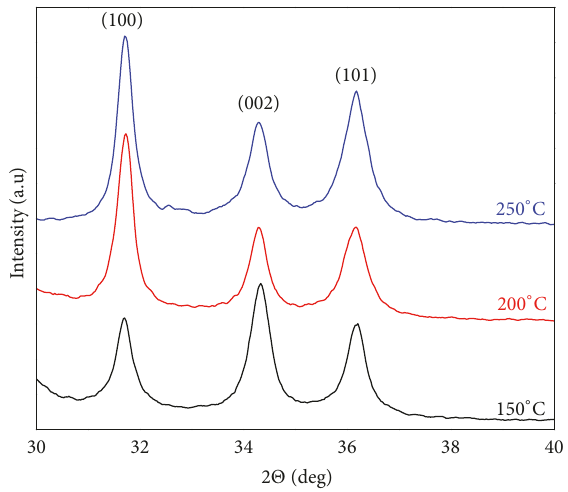
) in eV, and g , dir